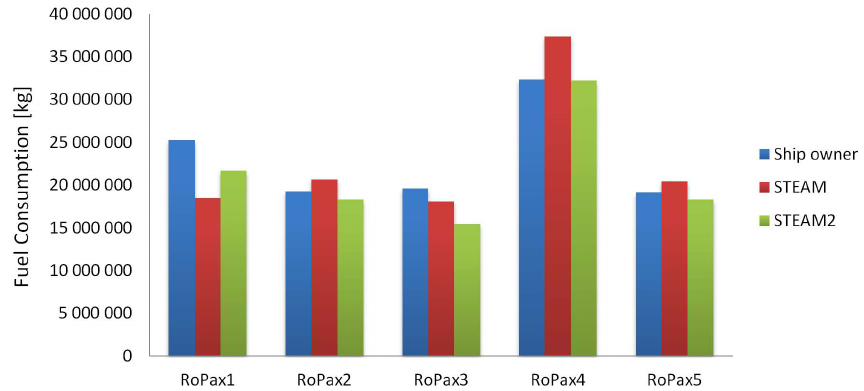
Fig. 9. The reported and predicted total fuel consumption for five RoPax vessels from January to November in 2007. The vessel RoPax 4 is the same ship, the data of which has been presented in Fig.